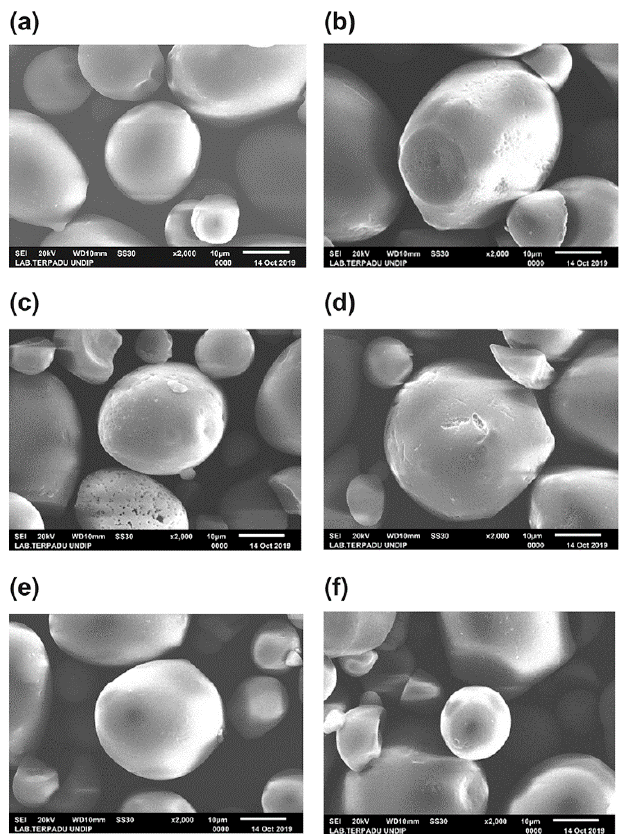
Figure 13. Scanning electron micrographs of sago starches. ( a ) Native starch. ( b ) Modified starch with ozone-oxidized treatment at pH 4 and a starch concentration of 30%. ( c ) Modified starch at pH 10% and 20% starch. ( d ) Modified starch at pH 7 and 20% starch. ( e ) Modified starch at pH 4 and 20% starch. ( f ) Modified starch at pH 4 and 10% starch. Magnification: 2000×.